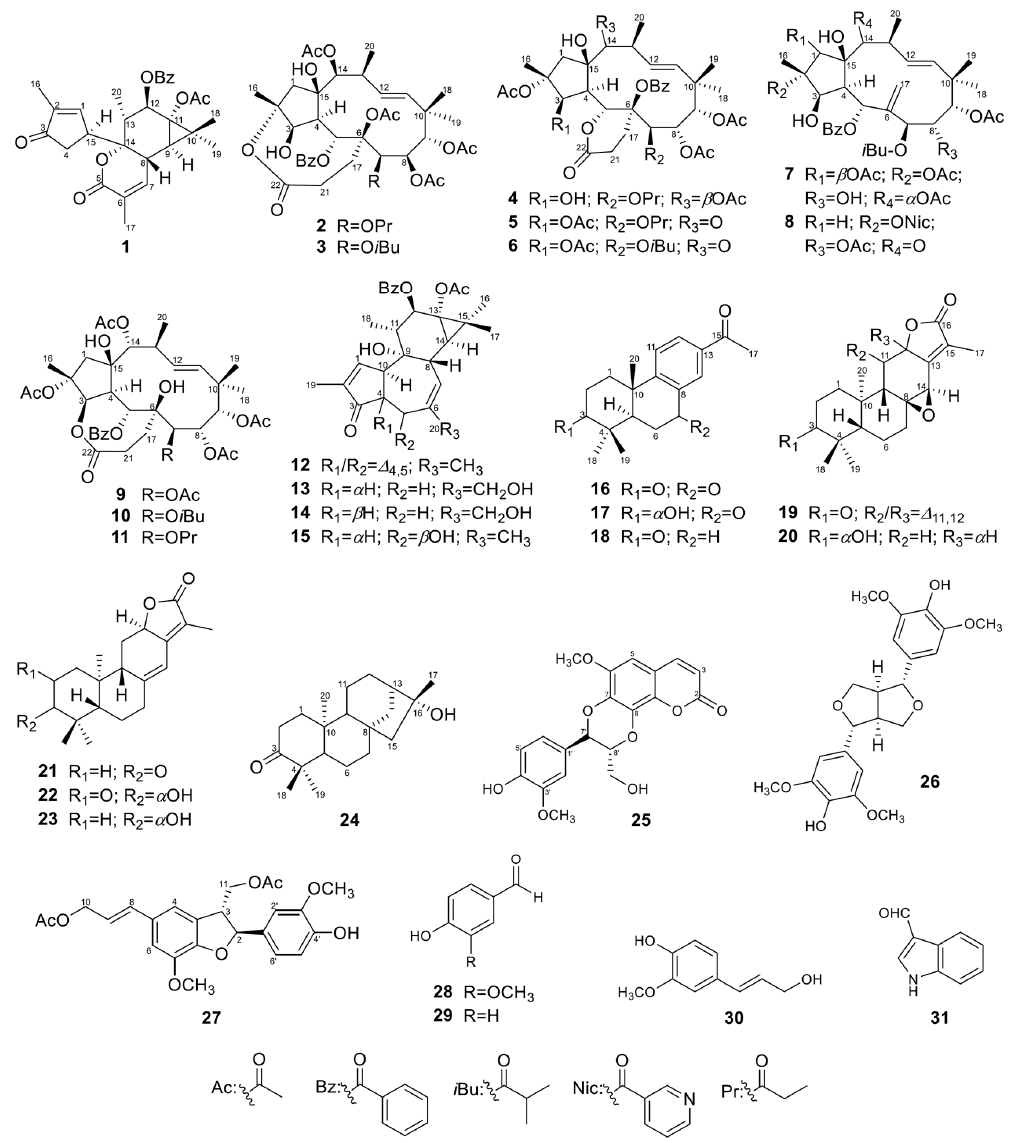
Figure 2. Structures of compounds 1 − 31 isolated from E. usambarica .